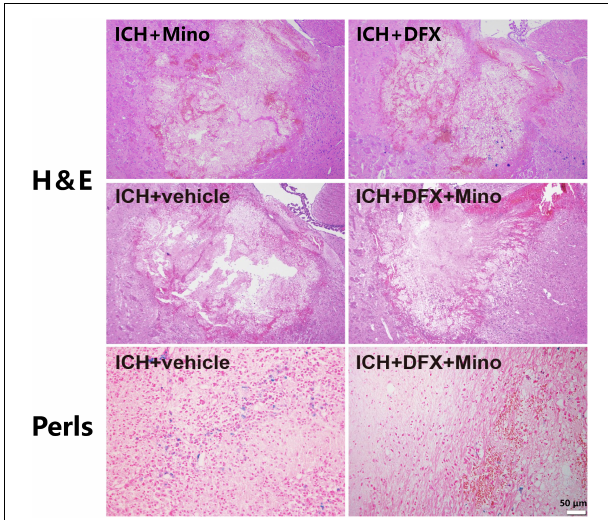
FIGURE 2 | The combined therapy of deferoxamine and minocycline attenuated iron deposition and reduced the area of brain damage after ICH. Paraffin sections from rats at day 3 after ICH were analyzed, and representative images of Hematoxylin and Eosin staining showing the brain damage area, and Perls’ blue staining to reveal iron-labeled cells, are displayed. Scale bar, 50 µ